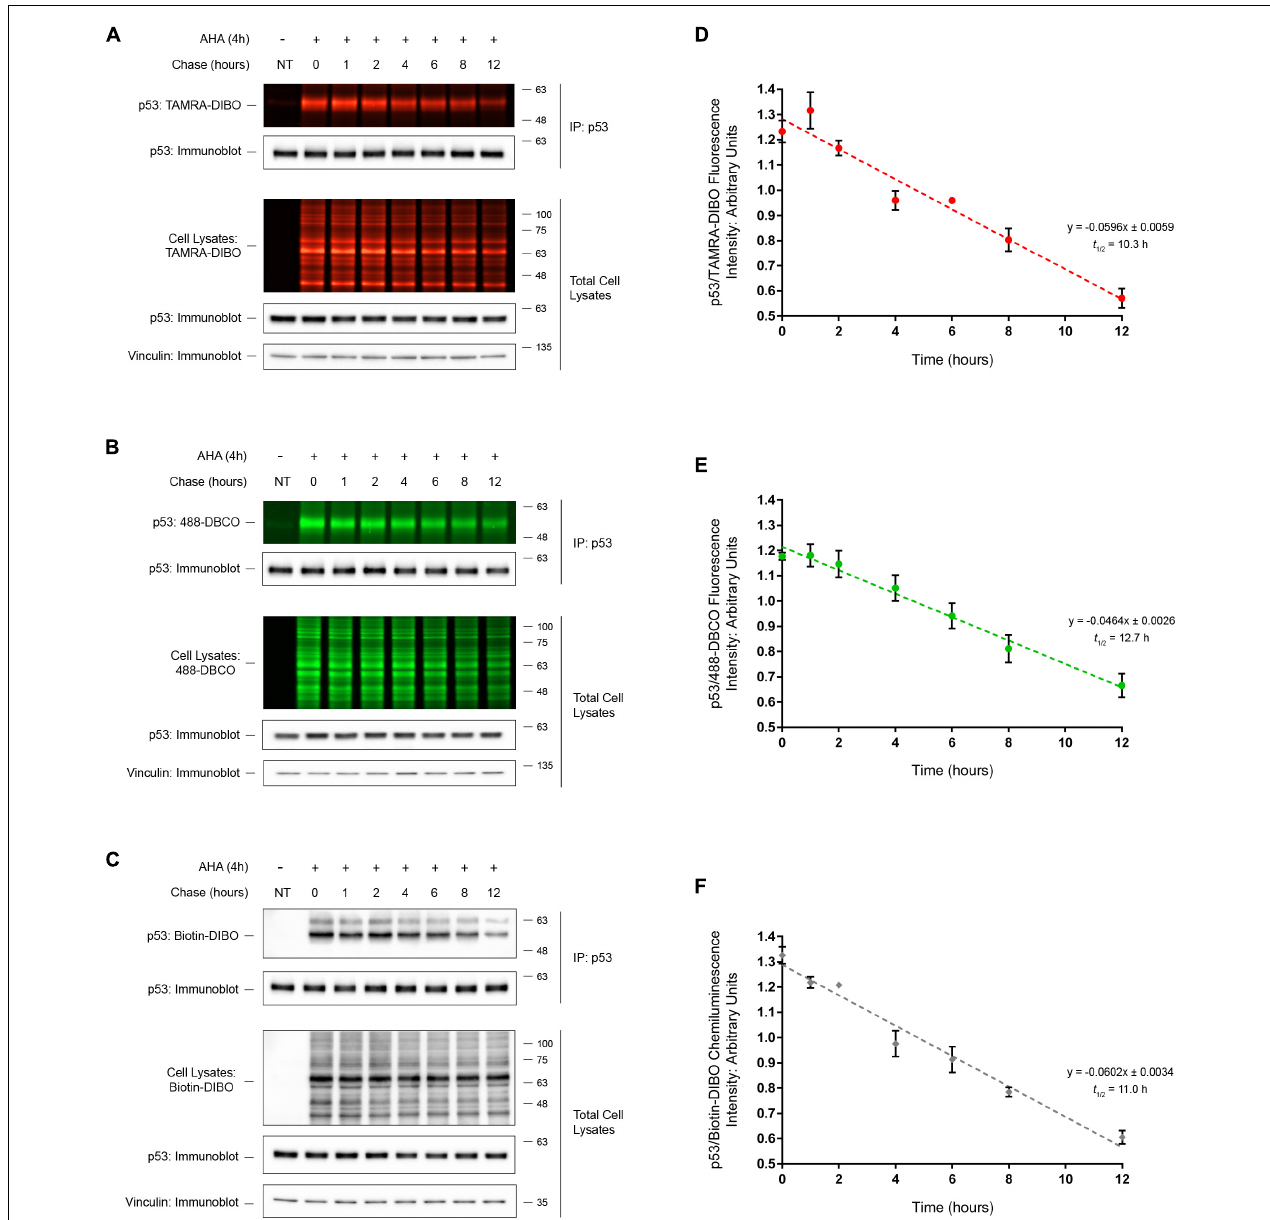
FIGURE 5 | Half-life determination of p53 by SPAAC pulse-chase. Detection of immunoprecipitated (IP) endogenous AHA-labeled p53 from HEK293 cells following SPAAC pulse-chase (4 h AHA pulse, 0–12 h methionine chase) with the strained cyclooctynes TAMRA-DIBO (A) , 488-DBCO (B) , or Biotin-DIBO (C) . Control unlabeled cells were incubated in media with methionine (i.e., without AHA). AHA/cyclooctyne-labeled proteins from either whole cell lysates or anti-p53 IPs were resolved on SDS-PAGE gels and AHA-labeled proteins were detected in-gel at an Ex/Em of either 555/580 nm ( A ; TAMRA-DIBO) or 494/517 nm ( B ; 488-DBCO). Alternatively, AHA-labeled proteins reacted with Biotin-DIBO (C) were resolved on SDS-PAGE gels, then transferred to PVDF membranes and detected by chemiluminescence using a HRP-conjugated streptavidin. Anti-p53 and anti-vinculin immunoblots were completed on AHA/cyclooctyne-labeled protein samples for downstream data analysis and as loading controls. The protein half-life of AHA-labeled p53 when reacted with three different strained cyclooctynes was determined to be 10.3 h ( D ; TAMRA-DIBO), 12.7 h ( E ; 488-DBCO), or 11.0 h ( F ; Biotin-DIBO). Fluorescent or chemiluminescent intensities from immunoprecipitated p53 were plotted on a linear scale and linear regression analysis was completed to determine p53 protein half-life ( n =